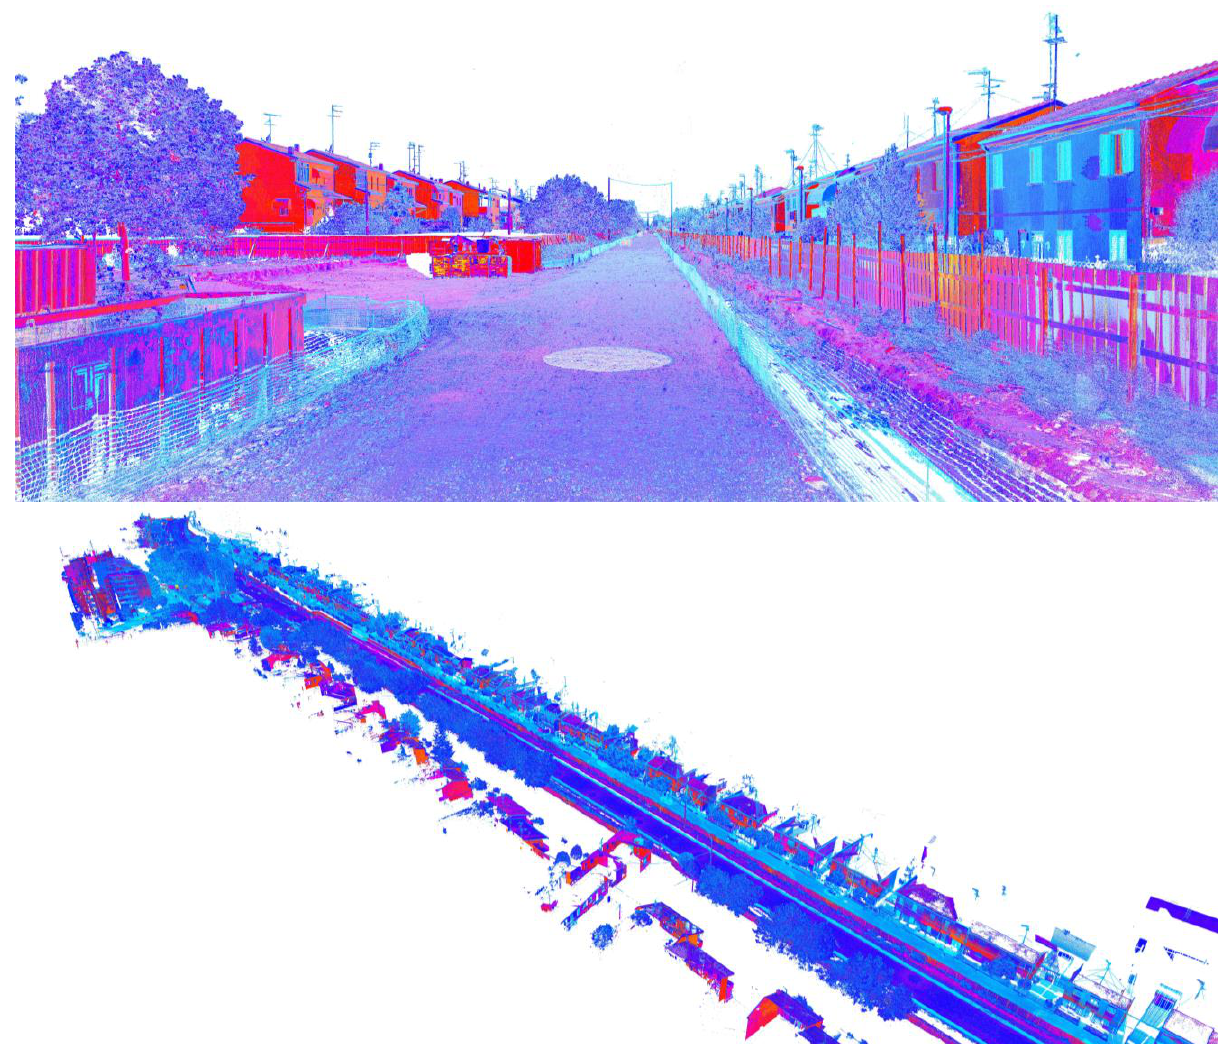
Figure 1. Views of the overall point cloud model of the new railway